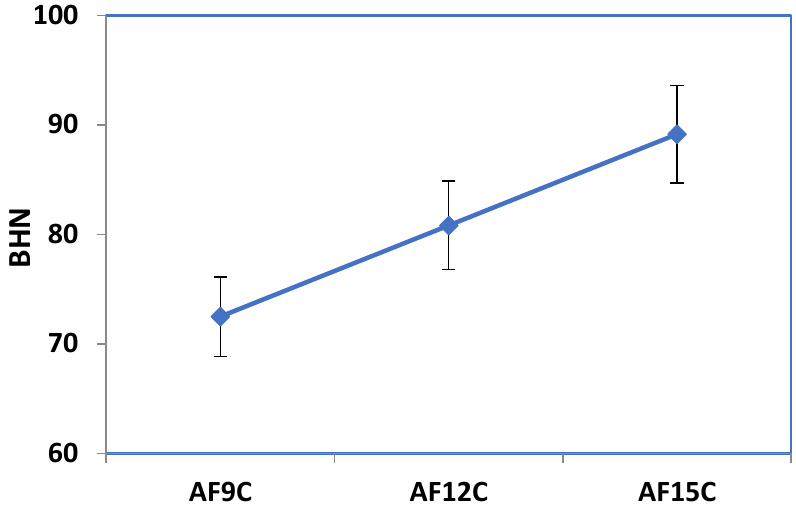
Figure 11. Hardness value of the different composites.